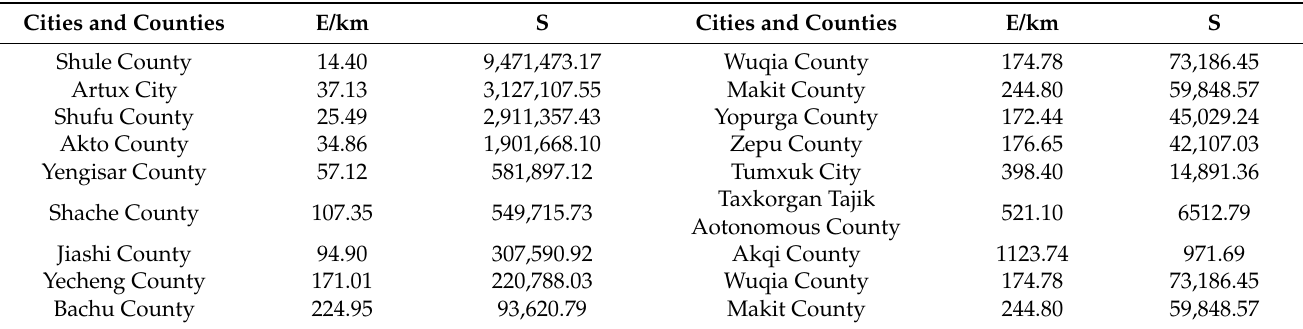
Table 5. The economic distance (E) and gravity (S).